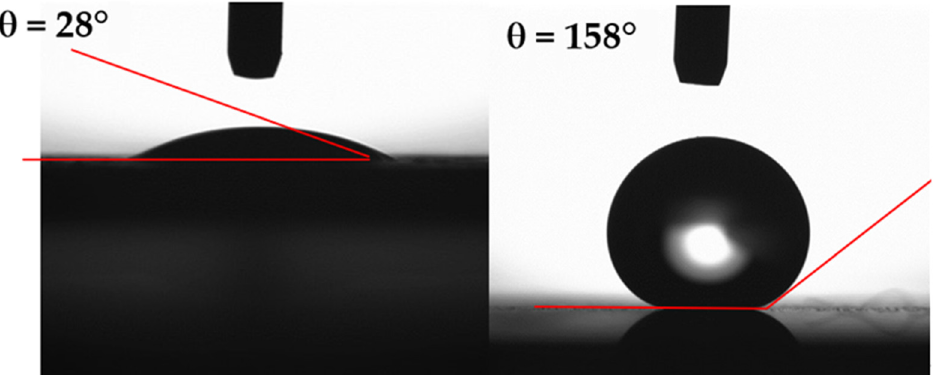
Figure 4. Goniometer images of a water droplet on the etched and hydrophobized etched silicon